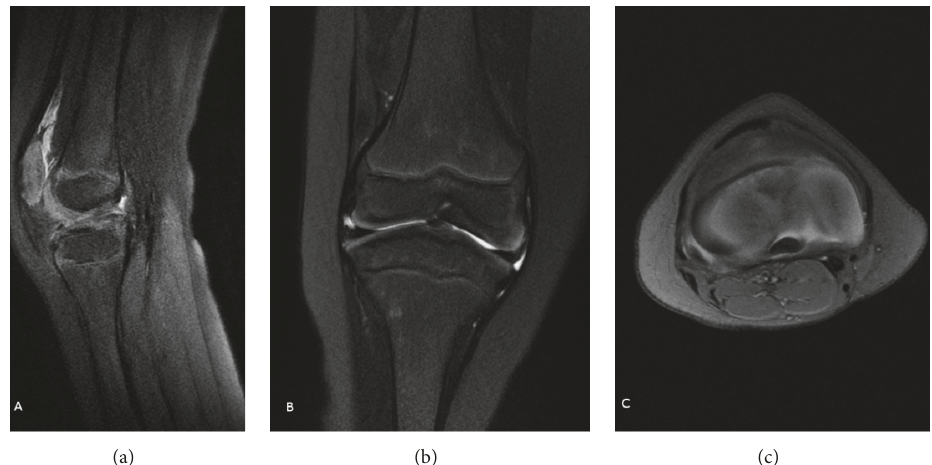
Figure 3: Preoperative MRI (sagittal (a), coronal (b), and transverse (c) views) of the right knee of the patient from Figures 1 and 2 showing the same findings as those in the left knee.